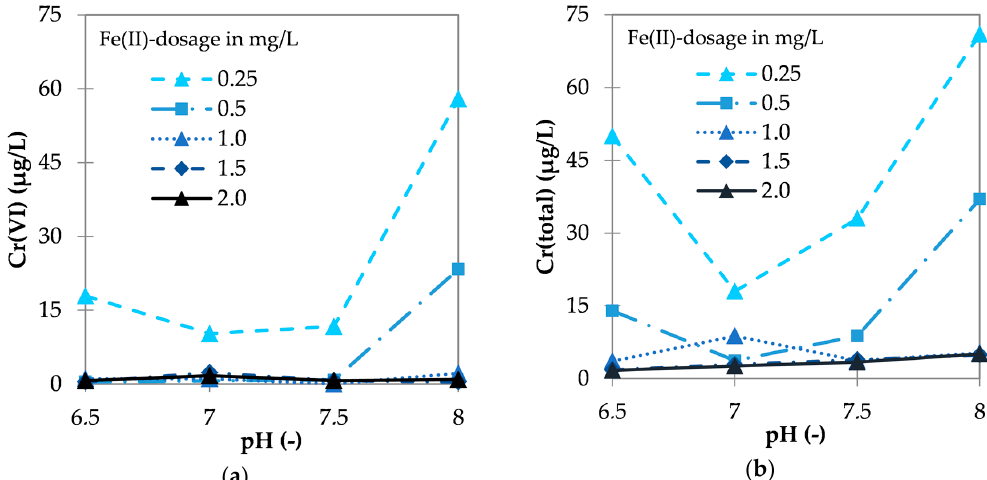
Figure 3. Residual concentrations of ( a ) Cr(VI) and ( b ) Cr(total) after 60 min of slow stirring as a function of pH value. Fe(II) dosages of 0.25, 0.5, 1, 1.5, and 2 mg/L and pH values of 6.5, 7, 7.5, and 8 were examined; all experiments were performed using set-up A.